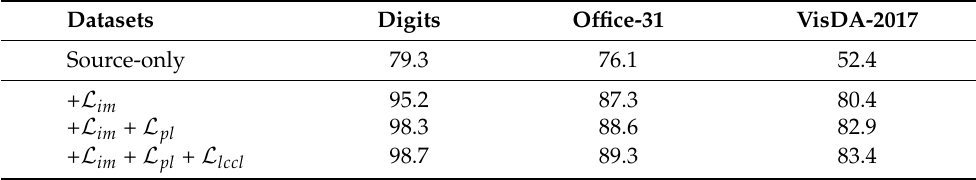
Table 4. Ablation study of our